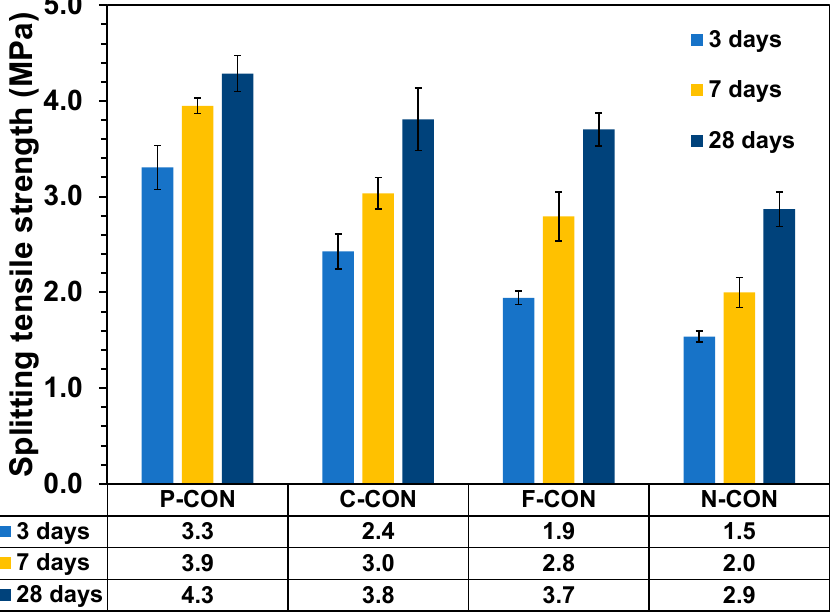
Figure 5. Split strengths of hardened concrete samples.